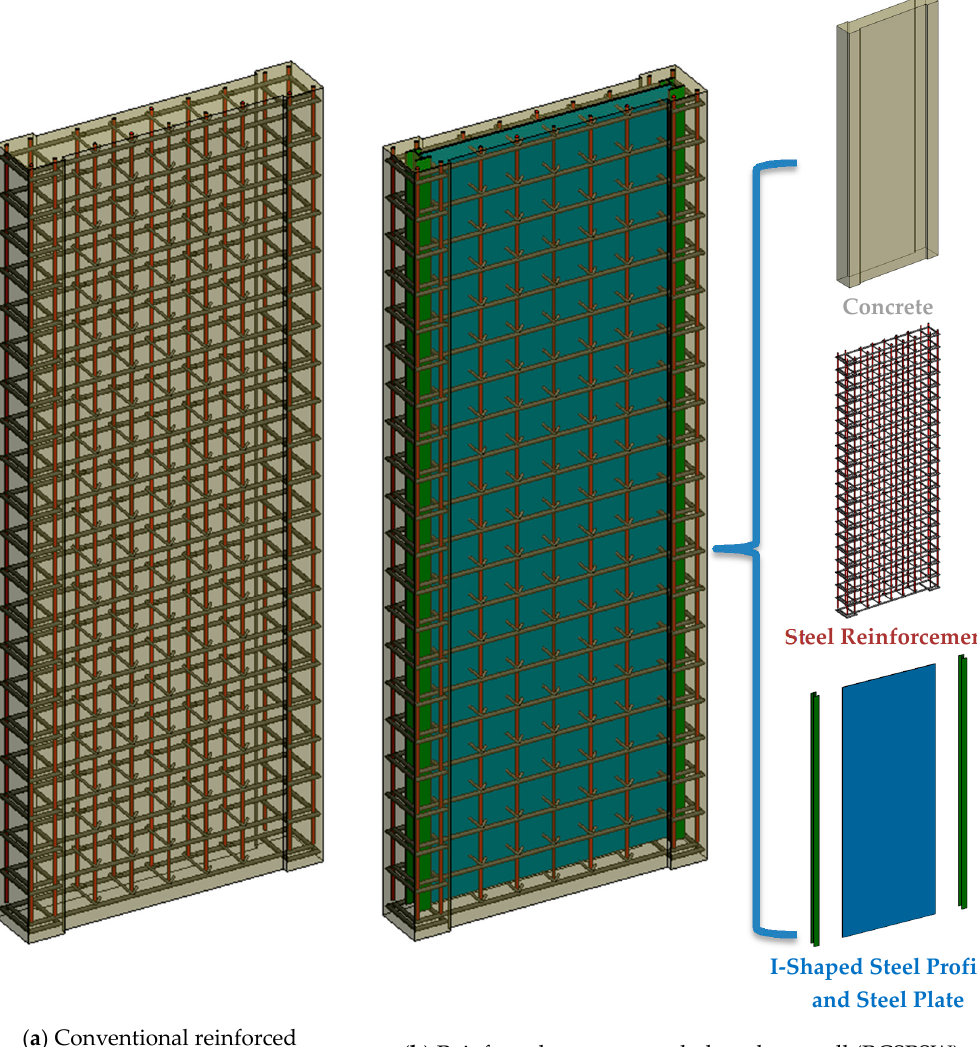
Figure 1. The Concept of Reinforced Concrete–Steel Plate Composite Shear Wall System.